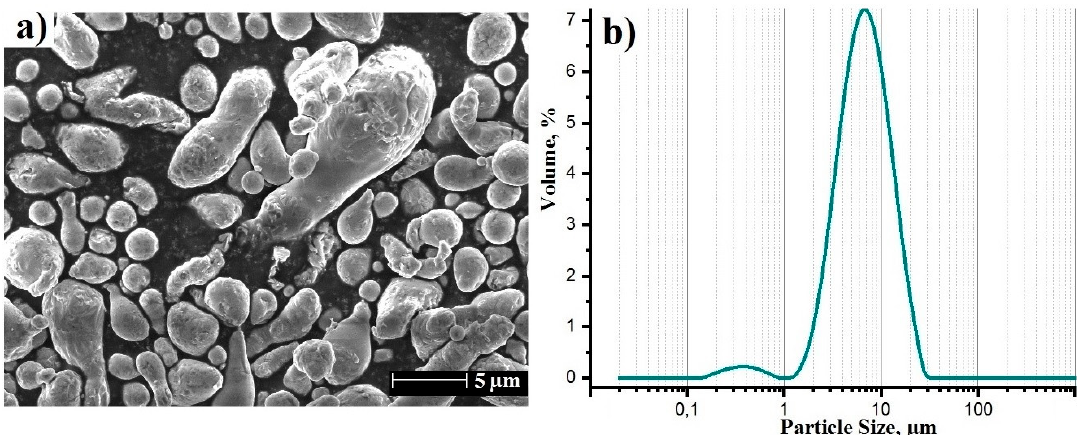
Figure 1. SEM image of the starting powder ( a ) and its particle size distribution ( b ).